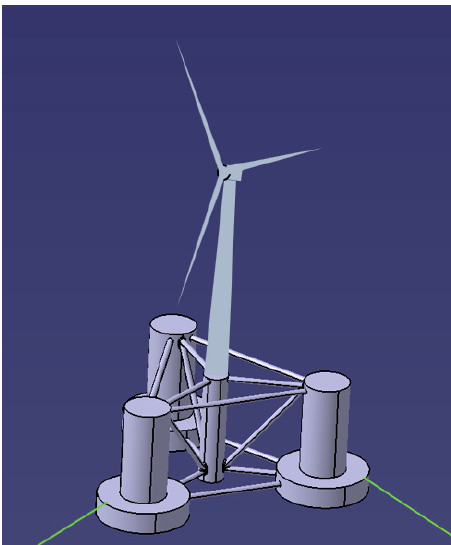
Figure 1. OC4 semi-submersible floating offshore wind turbine (FOWT) system. Table 1. OC4 semi-submersible properties.